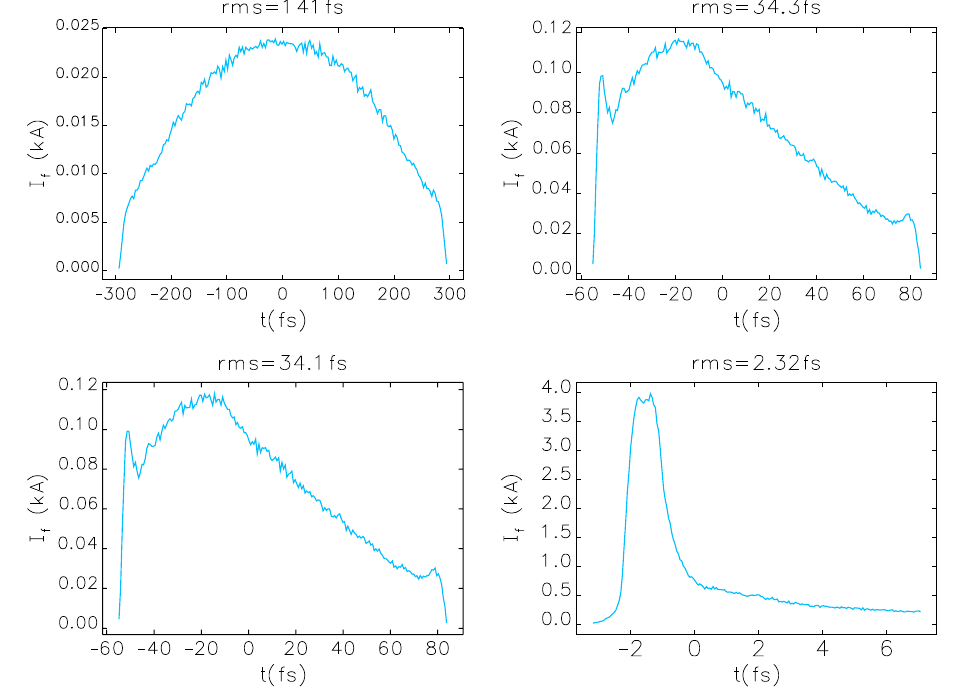
FIG. 6. Current profile evolution during the acceleration and bunch compression process. Observing locations from left top, right top to left bottom and right bottom: Linac1 end; bunch compressor one end; Linac2 end; bunch compressor two end. The rms electron bunch length is undercompressed from 140 to 34 fs in a first stage bunch compression, then further undercompressed to 2 fs in a second stage bunch